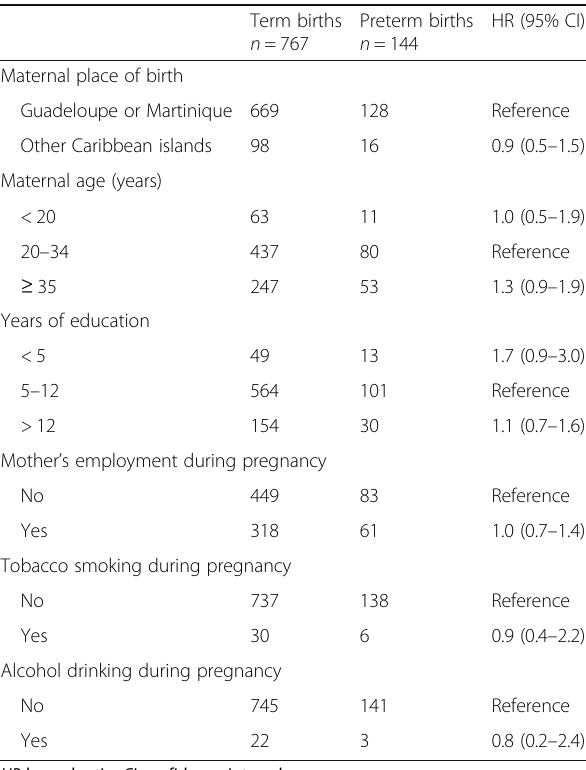
Table 2 Socio-demographic characteristics of the study population according to the pregnancy outcome (Timoun cohort, n = 911, Guadeloupe archipelago, 2004 – 2007) (from Rouget et al. 2013)